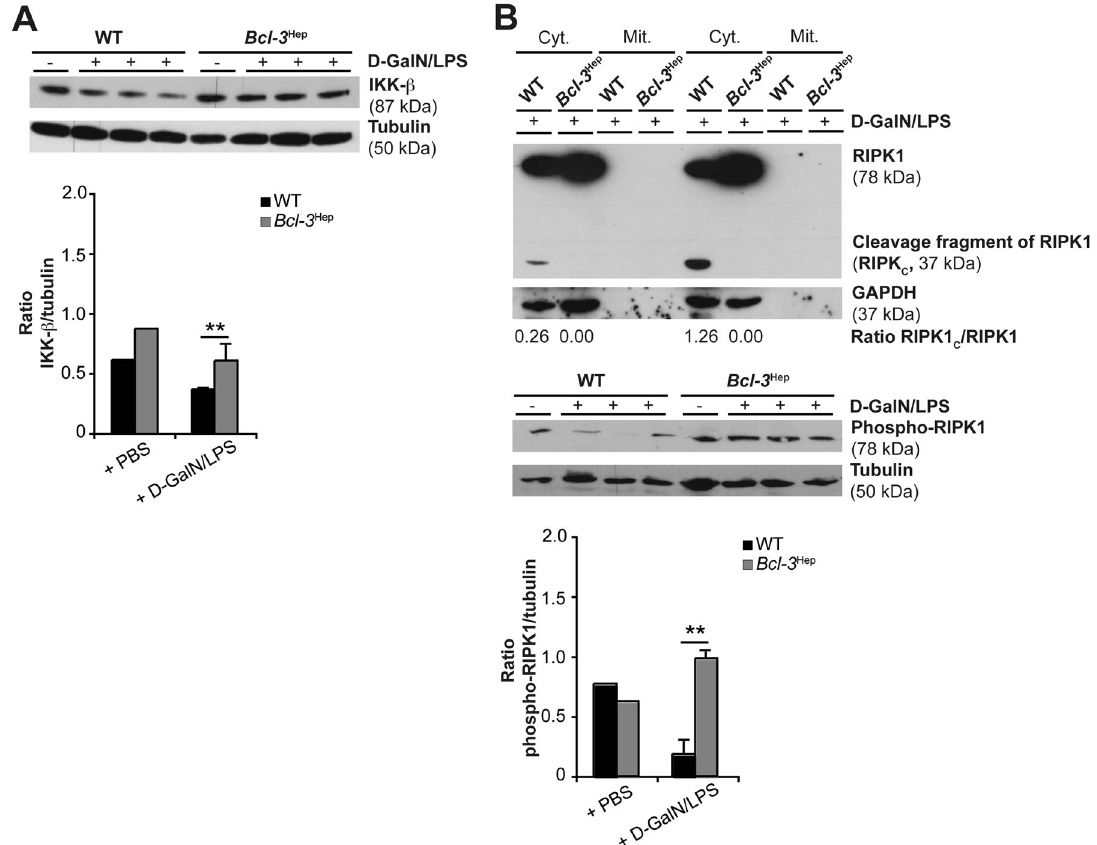
Fig. 5 Reduction of hepatic IKK- β , cleavage and Ser166-dephosphorylation of RIPK1 during apoptosis induced by d-GalN/LPS does not occur in Bcl-3 Hep mice. A Immunoblotting was performed with a speci fi c antibody against the C terminus of IKK- β in whole liver tissue lysates from Bcl-3 Hep and WT mice at 4 h after d-GalN/LPS challenge and corresponding controls. B To test the involvement of RIPK1 in d-GalN/LPS- induced liver injury, RIPK1 protein levels were analyzed in cytosolic (cyt.) and mitochondrial (mit.) protein fractions from two representative Bcl-3 Hep and WT mice treated with d-GalN/LPS. Phospho-RIPK1 (Ser166) levels were determined in whole liver homogenates from Bcl-3 Hep and WT mice at 4 h post D-GalN/LPS or PBS injection. In A and B representative western blots with densitometric analysis are shown. Tubulin and GAPDH served as protein loading controls. ** p < 0.01 for WT vs. Bcl-3 Hep according to an unpaired, two-tailed Student ’ s t -test ( A and B